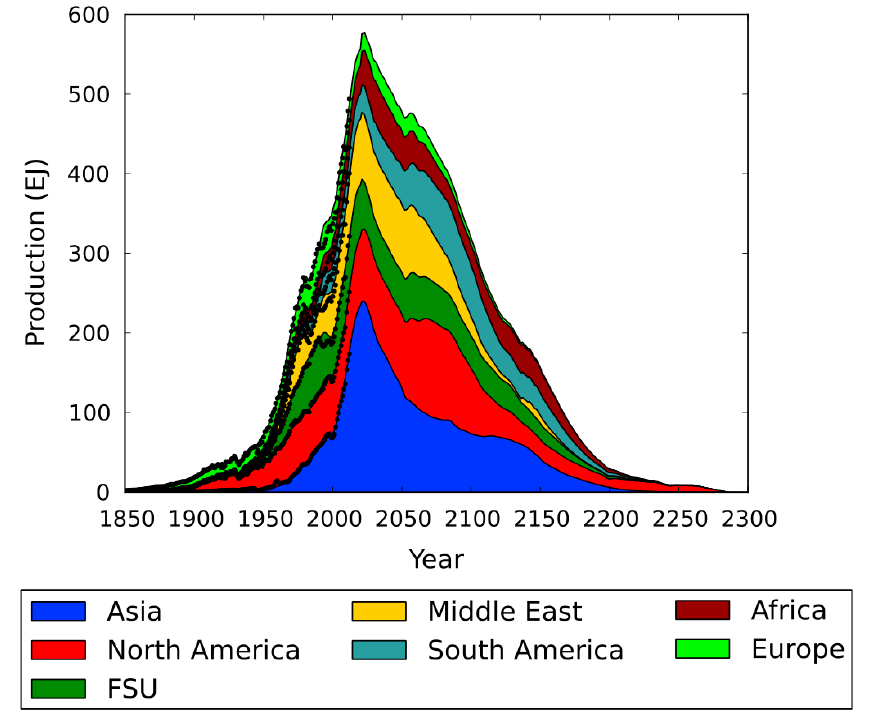
Figure 2. Fossil fuel use and projections (black dots represent actual production) [10].